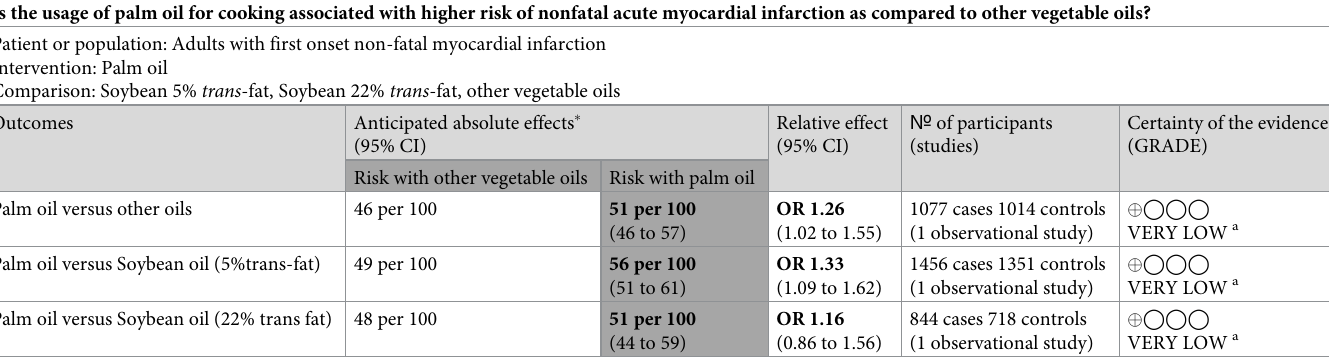
(cid:3) The risk in the intervention group (and its 95% confidence interval) is based on the assumed risk in the comparison group and the relative effect of the